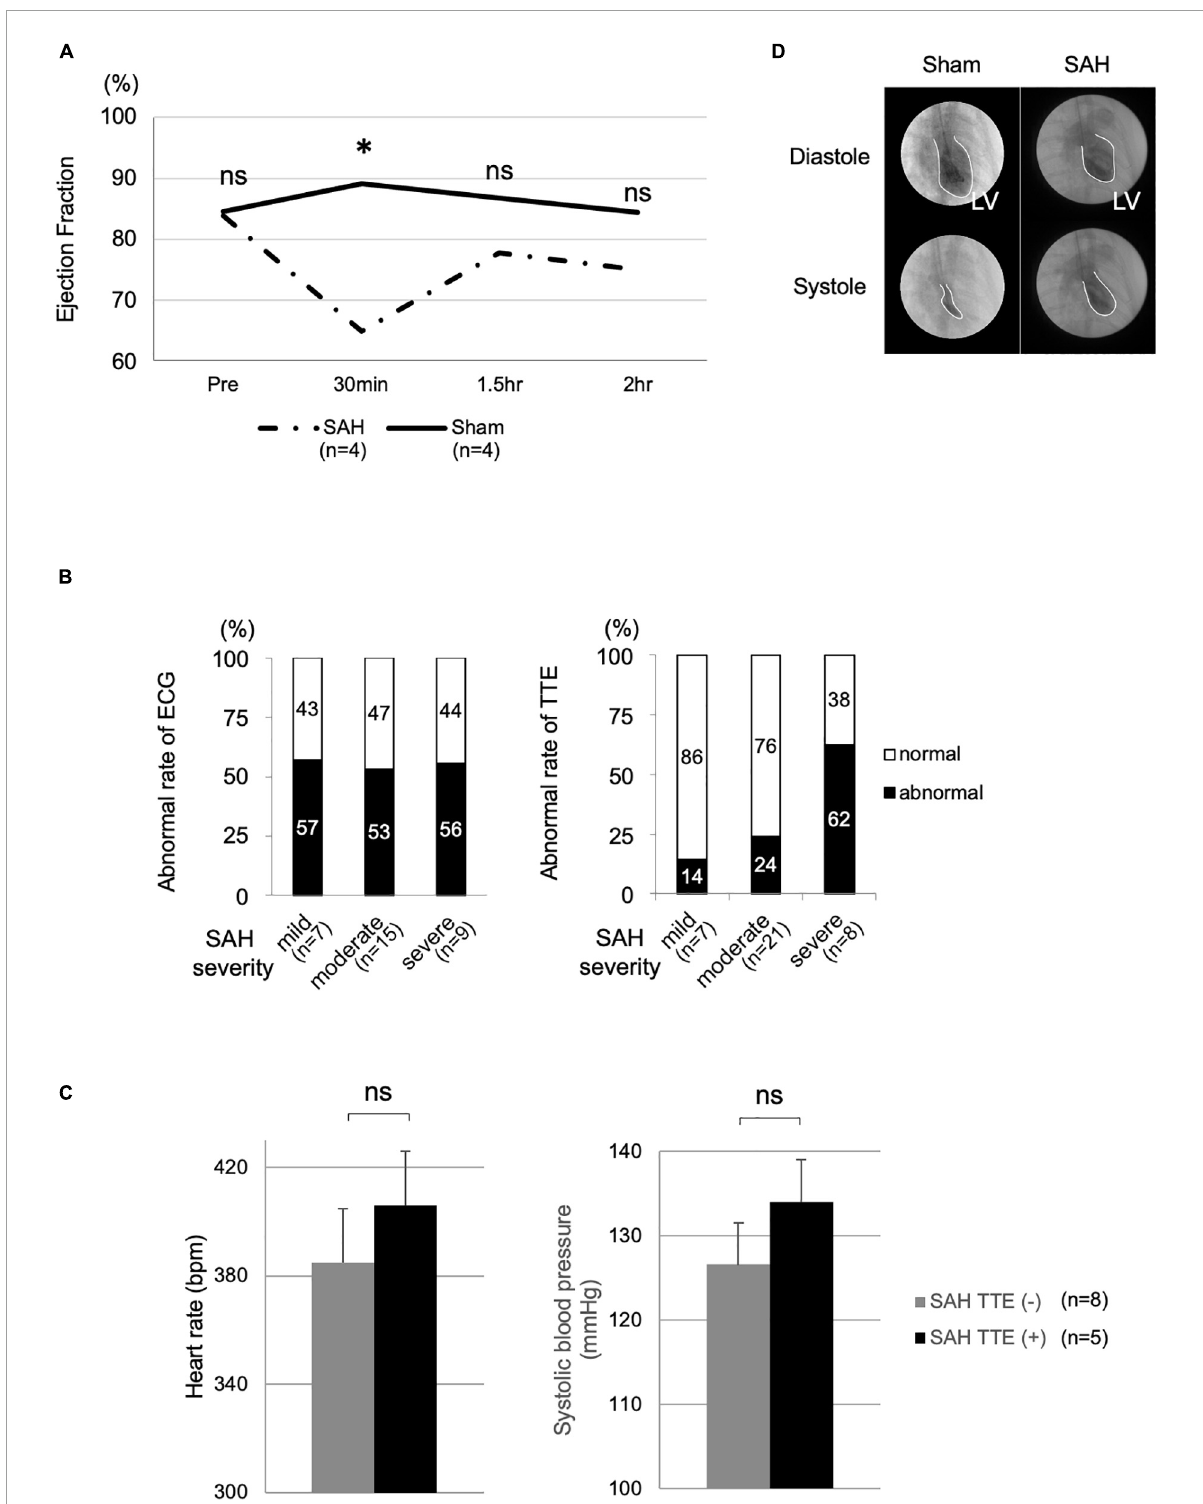
FIGURE2 Cardiac dysfunction and vital signs in the SAH and sham groups. (A) TTE measurements of the SAH ( N = 4) and sham ( N = 4) groups at various time points. (B) Correlations of the rates of ECG (mild, N = 7; moderate, N = 15; and severe, N = 9) and TTE changes (mild, N = 7; moderate, N = 21; and severe, N = 8) with SAH severity. (C) Heart rate and systolic blood pressure in the SAH group with TTE change [SAH TTE (+), N = 5] and the SAH group without TTE change [SAH TTE ( − ), N = 8]. (D) Cardiac function analysis using LVG. Bpm, beats per minute; ECG, electrocardiography; LV, left ventricle; LVG, left ventriculography; ns, not significant; SAH, subarachnoid hemorrhage; and TTE, echocardiography. *Indicated P <